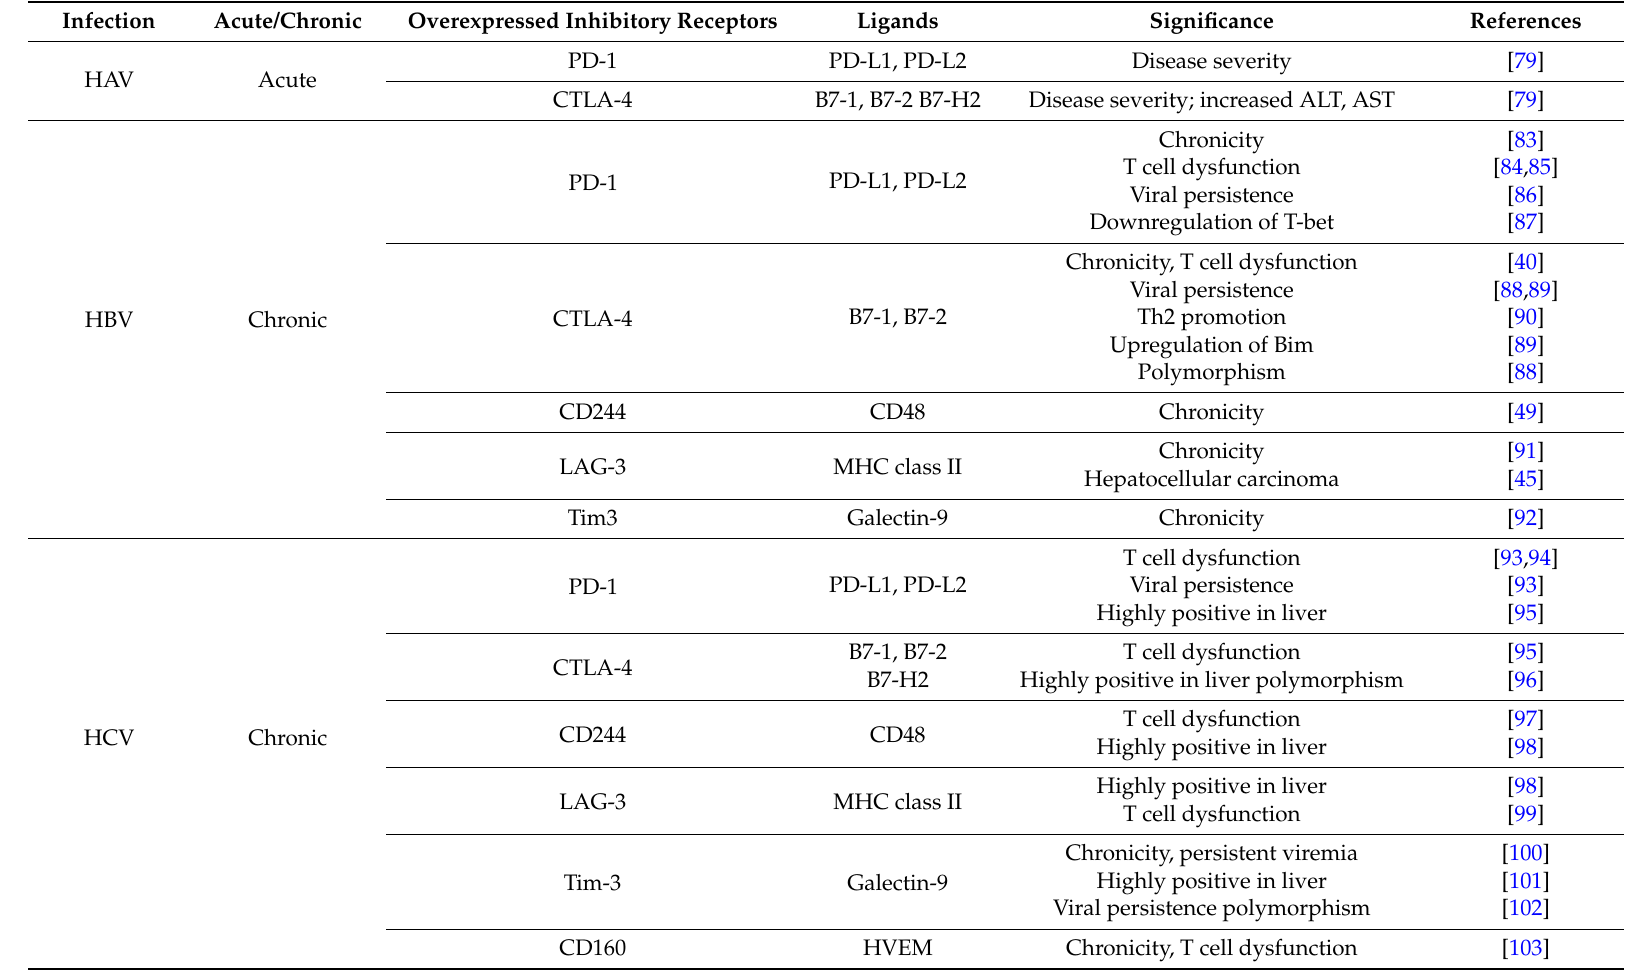
Table 1. Overexpressed inhibitory receptors in viral